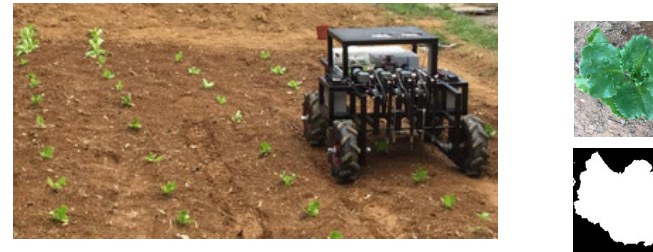
Figure 6. Example of a robot for removing weeds [85].